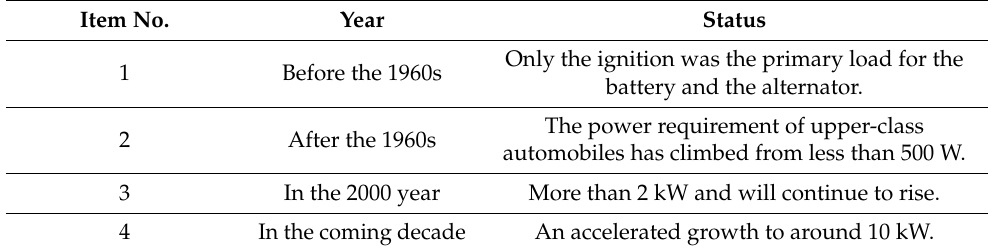
Table 1. Summary for the power demand associated with the load for autonomous systems. Item No.